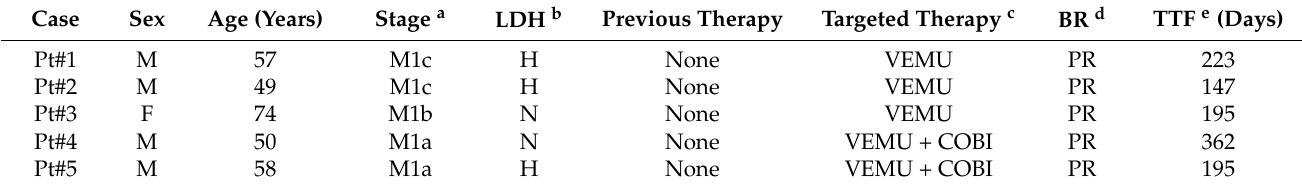
Table 2. Demographic and clinical characteristics of melanoma patients from whom plasma was collected.